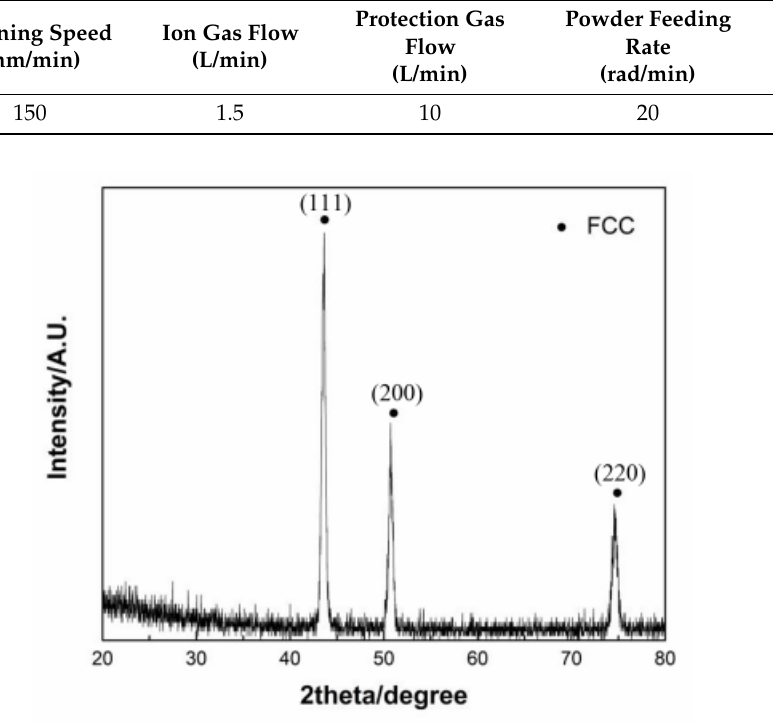
Figure 3. Microstructure of the grey cast iron .